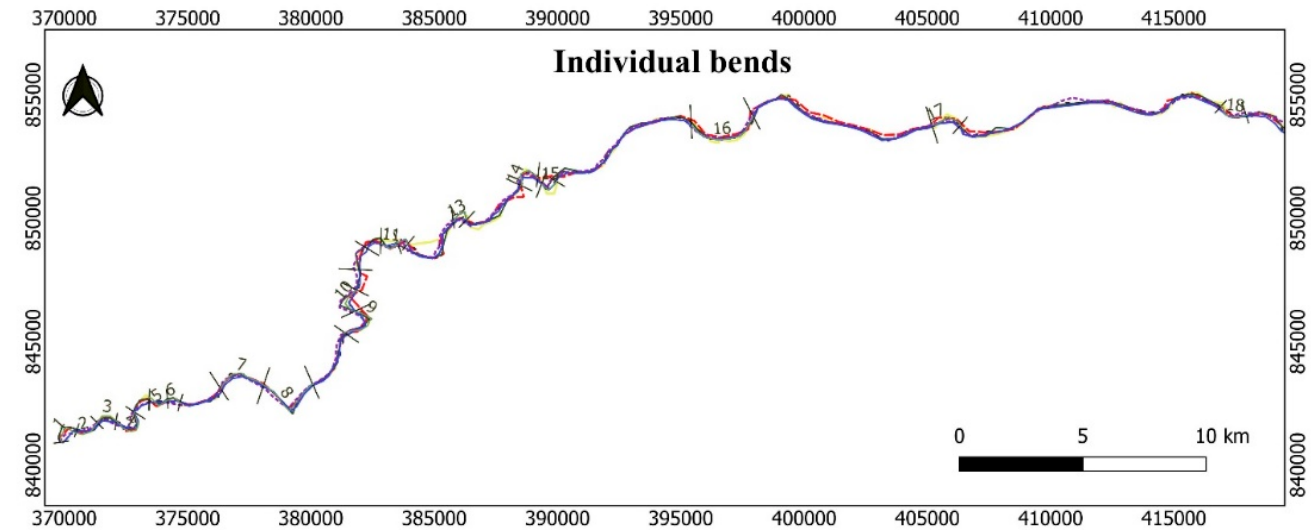
Figure 9. Separation of individual meander bends along the Deduru Oya.